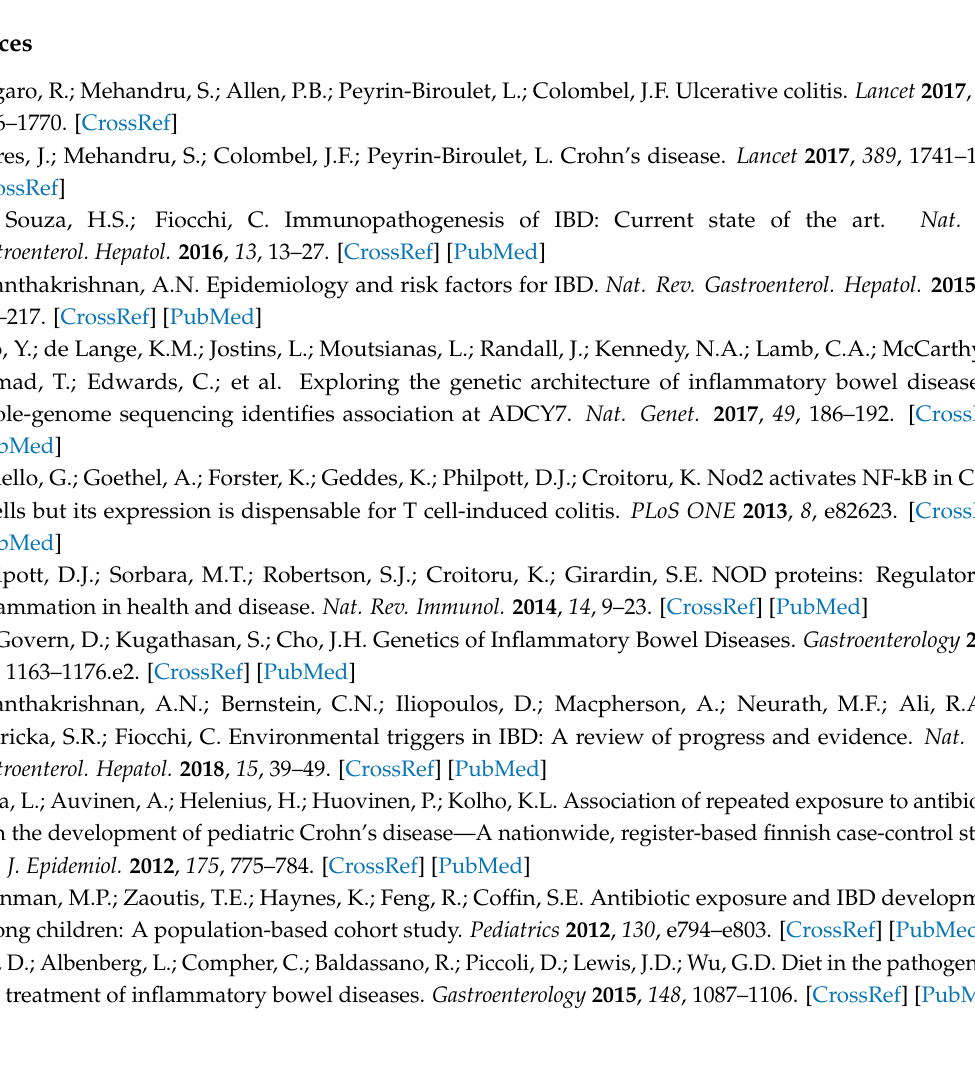
s1, Figure S1: Histological characterization of the experimental groups. Figure S2: Principal component analysis (PCA) of total bacterial genera found in feces of mice. Figure S3: A Bronze-enriched diet affected the fecal bacterial species of WT and Winnie mice. Table S1: Number of identified species (OTUs), Shannon diversity index and Chao 1 mean of the microbiota of C57BL/6 (WT) and Winnie mice fed with Control tomato or Bronze tomato supplemented chow (Bronze). Values within a column with different superscript letters are significantly different ( P < 0.05; FDR <